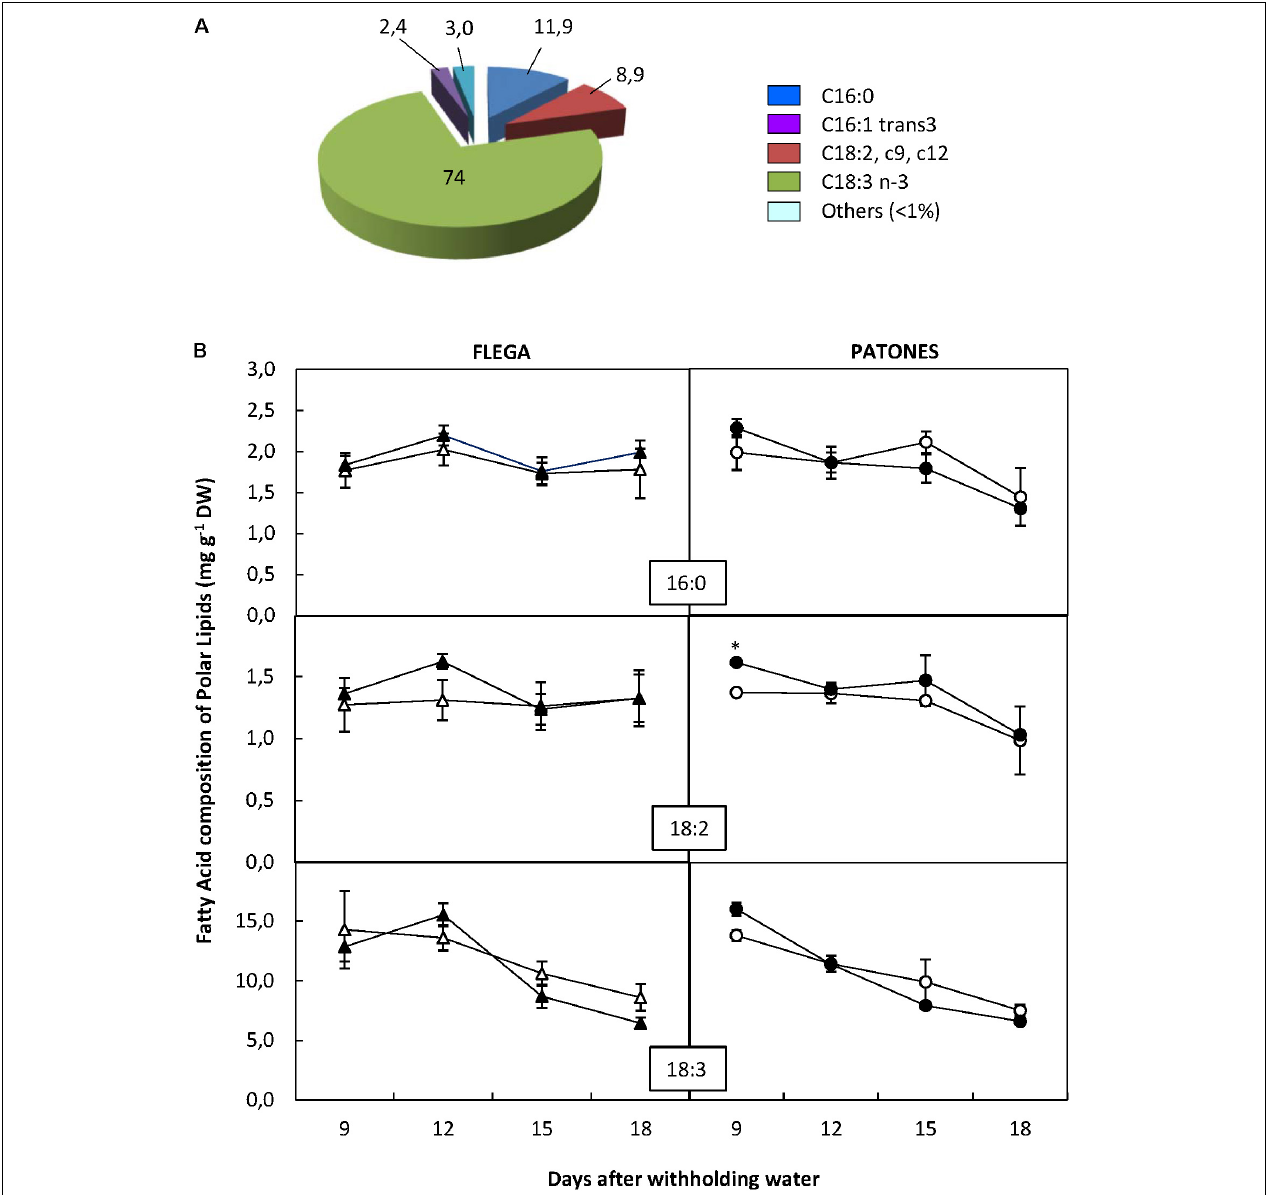
FIGURE 3 | Fatty acid content of Polar fraction. (A) Fatty acid distribution within polar fraction. The proportion of fatty acids detected in the polar fraction was calculated from a profiling of 92 fatty acids. (B) Fatty acid content. Fatty acids accounting for at least 5% of the fraction were quantified in drought susceptible Flega (triangles) and resistant Patones (circles) well-watered plants (open symbols) and during a time course of water stress (solid symbols) (9, 12, 15, and 18 days). Data are mean of five replicates ± standard error. ∗ , indicate significant differences at P < 0.05.